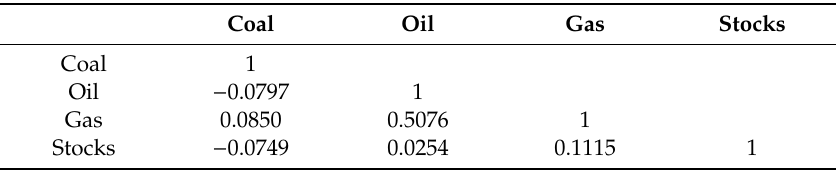
Table 17. Correlations for